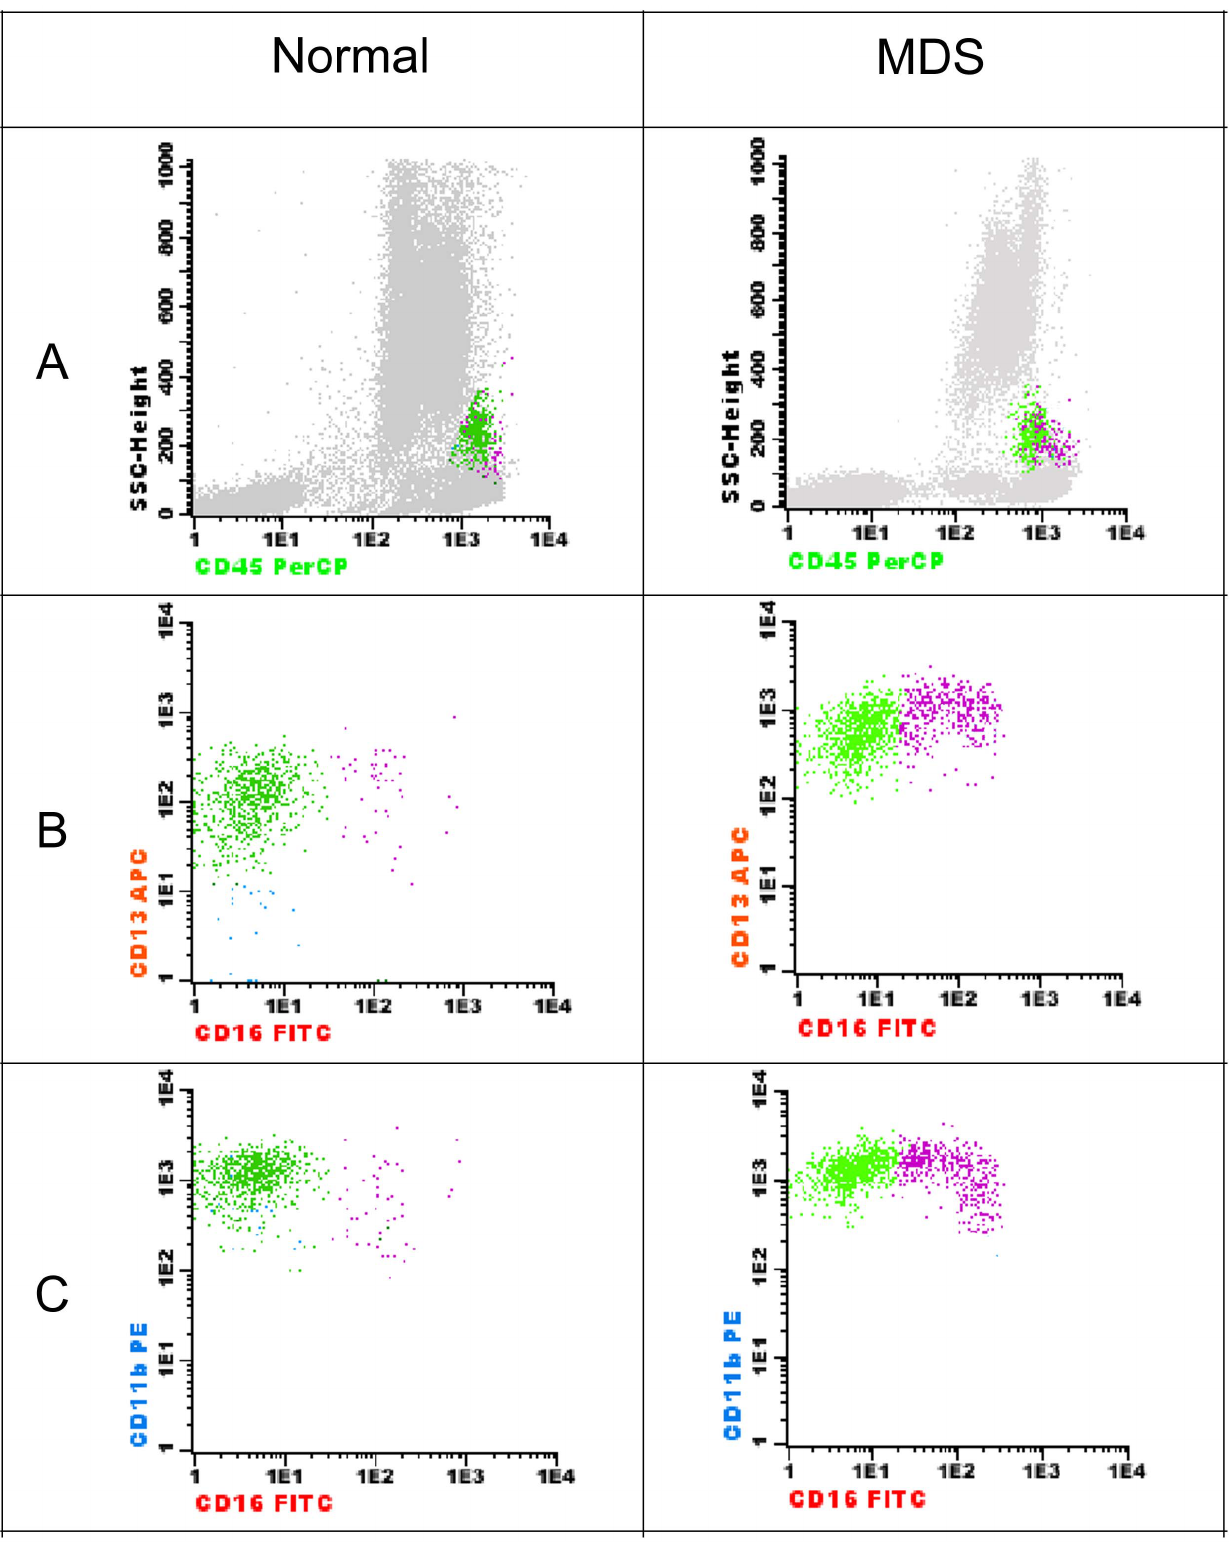
Figure 2. Detection of abnormalities in monocytes in the combination CD16/CD11b/CD45/CD13. Left: normal BM. Right: a case of RCMD (monocytes=2.4%). Abnormal continuous acquisition of CD16 in the mature monocytes (B).